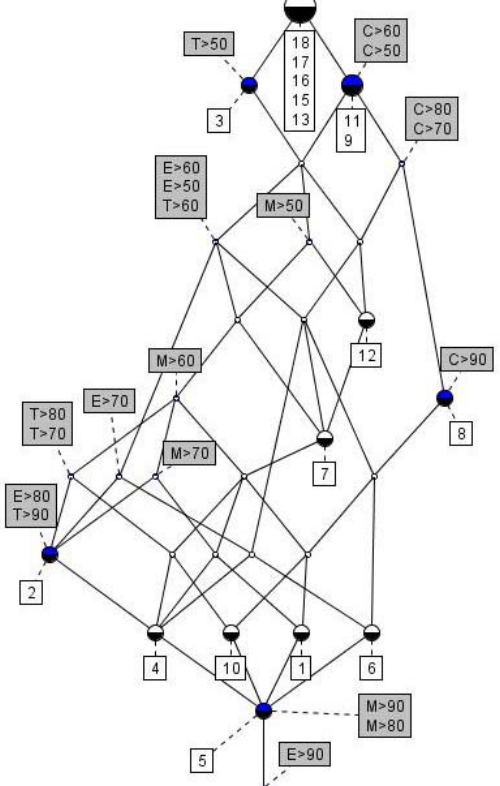
Figure 6 . Lattice line diagram for human health effects by 1,1-dimethyl hydrazine and its transformation products as derived by PASS